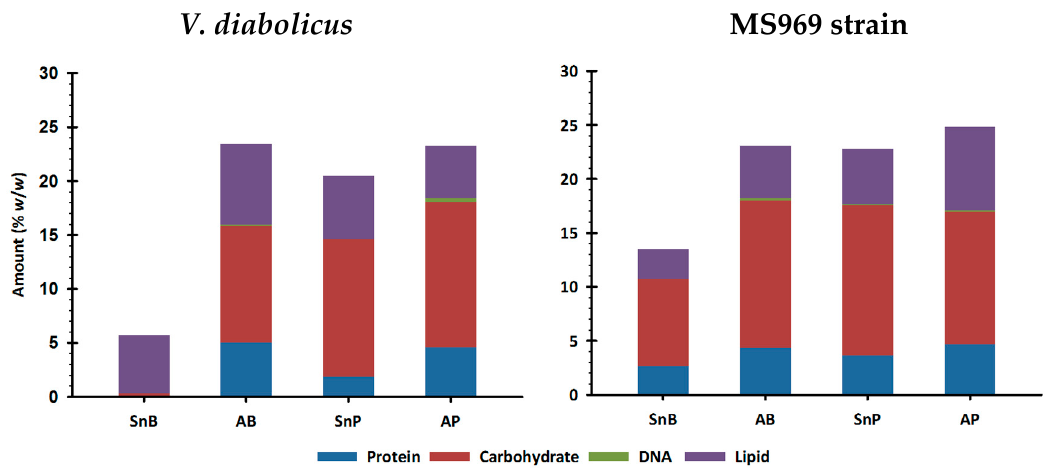
Figure 5. Composition analysis of supernatants (Sn) and NaOH extracts (A) from attached cells (B) or planktonic cells (P). Supernatants recovered directly using biofilm sample centrifugation were labeled “Sn” and those resulting from NaOH extraction were labeled “A.”